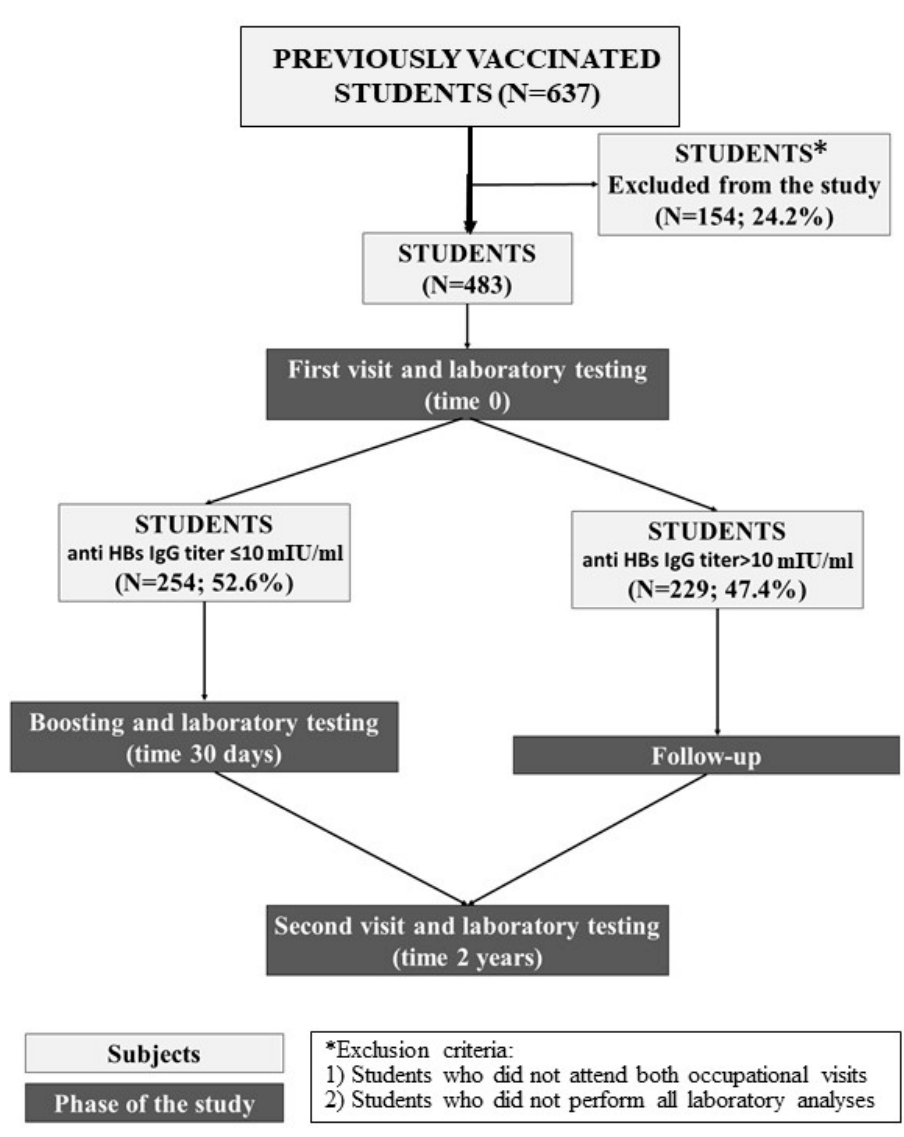
Figure 1. Flow-chart diagram according to the study phase (grey boxes: absolute frequencies of students; black boxes: phase of the study). Table 1. General characteristics of nursing students in relation to the median of serum antibodies against hepatitis B surface antigen (anti-HBs) IgG titers at the first visit.